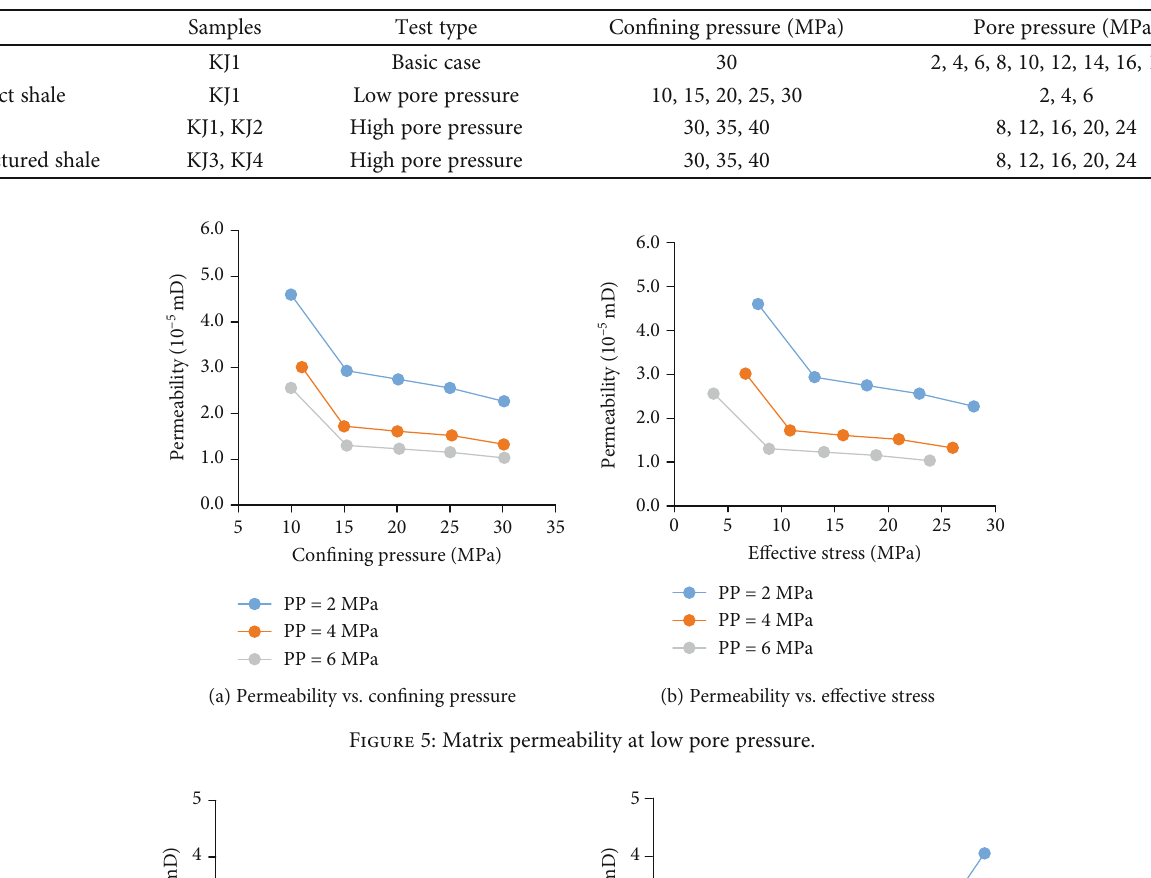
Table 2: Design of experiments.